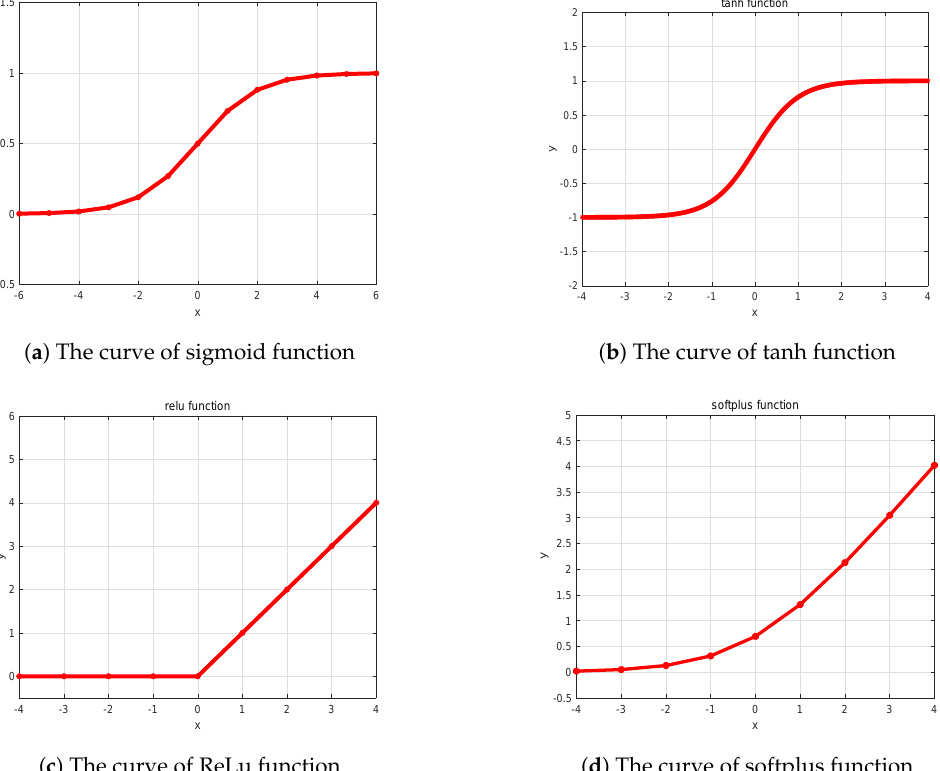
Figure 4. The graphs of four common different activation functions. The names of the above curve functions are: the sigmoid function, the tanh function, the ReLu function and the softplus